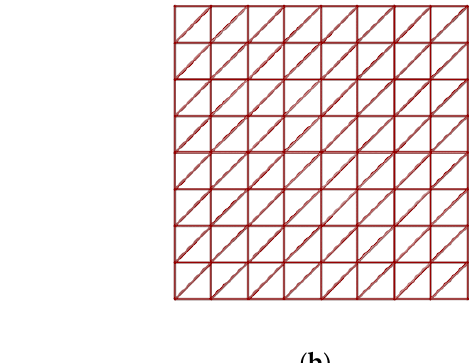
Figure 4. Rectangular projections of considered grid patterns: ( a ) the pattern—split along a short diagonal; ( b ) the pattern—split along a long diagonal.